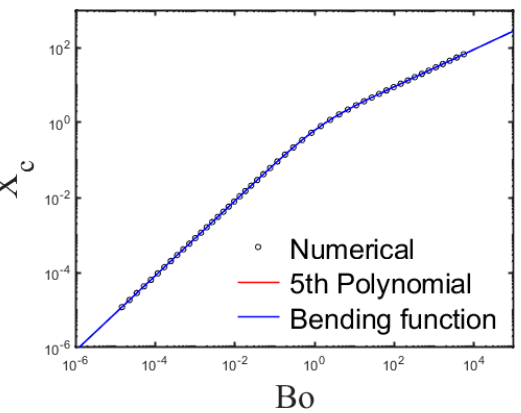
Figure 11. Comparison of the fitting results of the fifth-order polynomials and bending function for X c 𝑋 (cid:3030) .